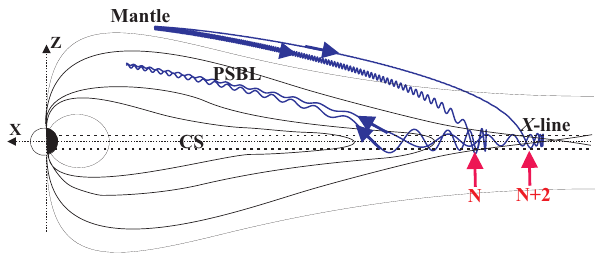
Fig. 44. Projection of typical trajectories of particles onto the ( X , Z ) plane as they move towards the CS from the source in the mantle, then interact with the CS at different resonant sites (having numbers N , N + 2) and are ejected from the CS forming field-aligned beam- lets moving Earthward. These beamlets intersect at some X location because of combining action of “place of birth” and velocity filter effects. The simulation of particle trajectories was performed in the 2-D Birn-Zwingmann equilibrium analytical magnetic field model using the constant uniform dawn-dusk electric field E